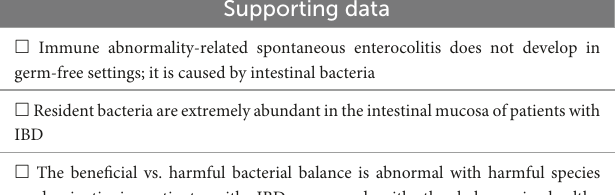
TABLE 3 Supporting data for the theory of intestinal bacteria as a cause of IBD. Supporting